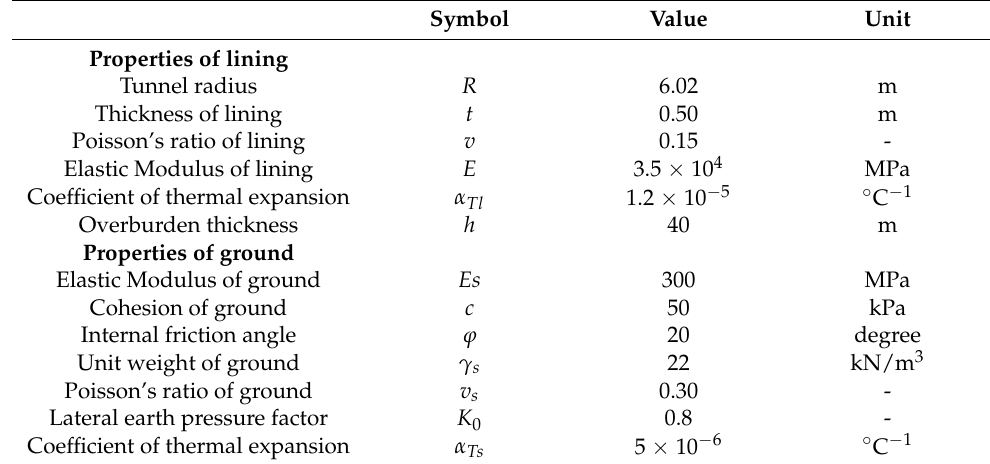
Table 3. Properties of the tunnel lining and